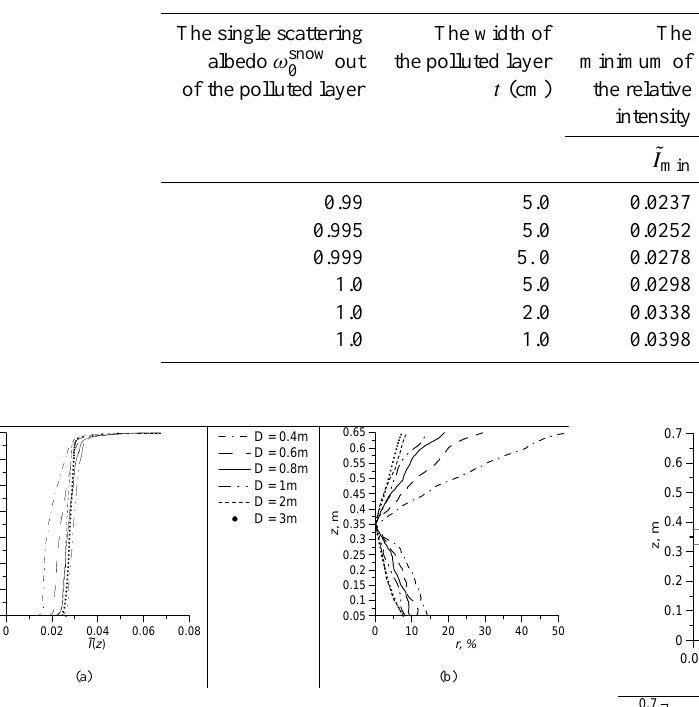
Table 1. The value of the minimum of the relative intensity ˜ I min and the width of the optical influence spread of the polluted layer t ∗ (cm) for different values of the single scattering albedo ω snow outside of the polluted layer at different widths of the polluted layer t . 0